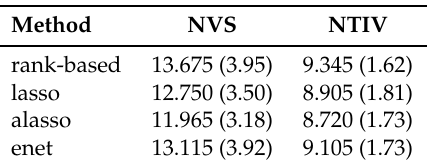
Table 6. Estimated mean and standard deviation of number of variables (NVS) selected and the number of true important variables (NTIV) among NVS in four different models under simulation scenario 2 with 200 replications. The values in parentheseses are standard deviations.